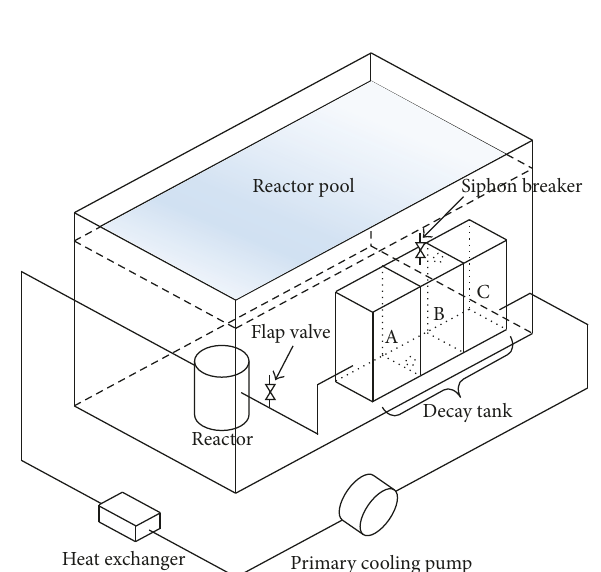
Figure 3: Schematic of integrated passive safety